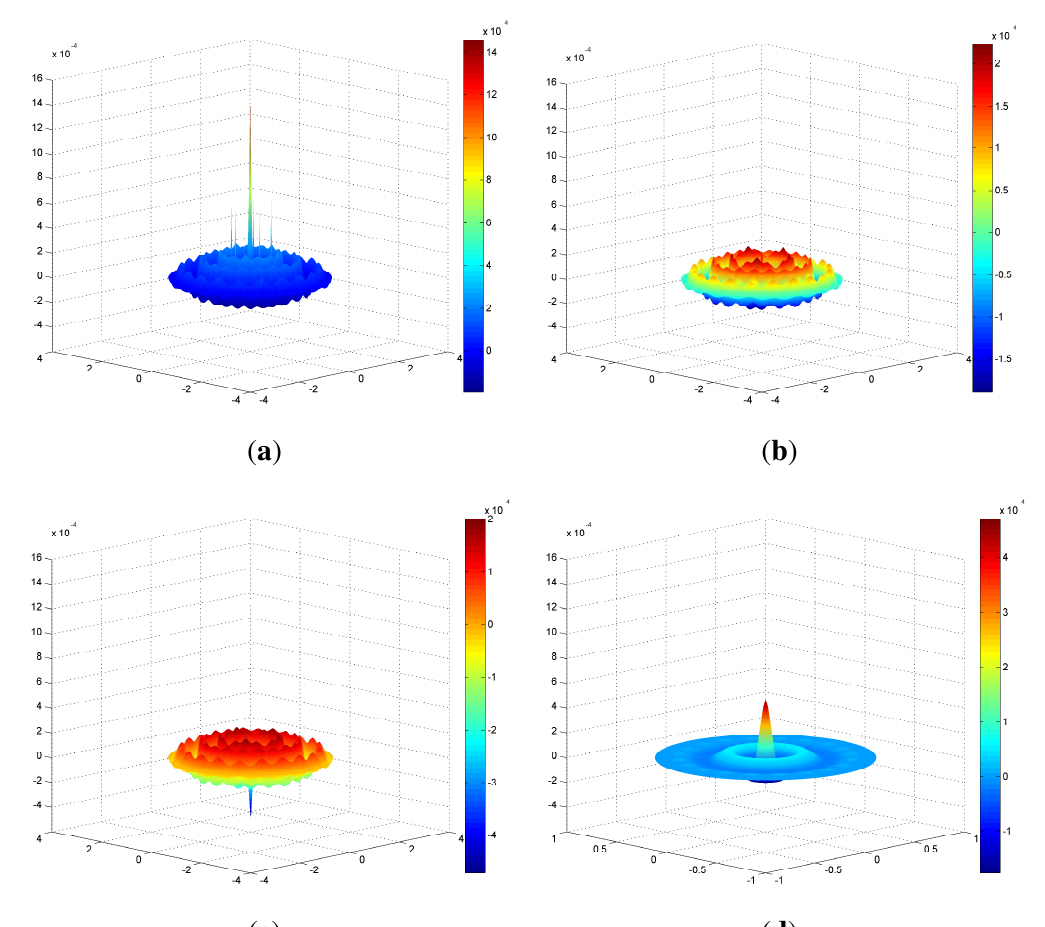
Figure 11. Poisson’s equation on Disk 1: difference graphs between the exact solution and the computed solution. ( a ) C 0 , bi-3; ( b ) G 1 bi-3/bi-5; ( c ) Catmull–Clark (level = 7), bi-3; ( d ) C 1 polar,